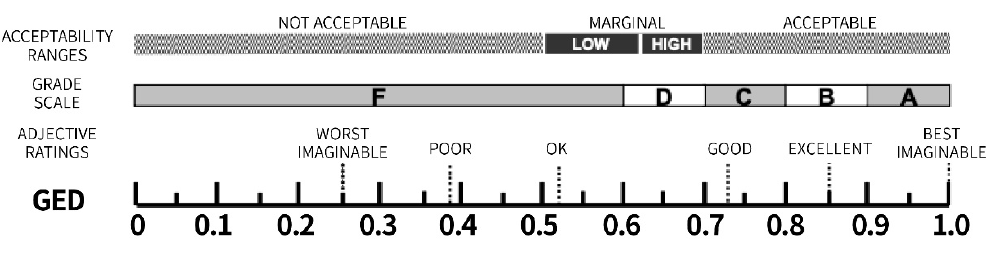
Figure 7. SUS scale of GED (based on [38]).